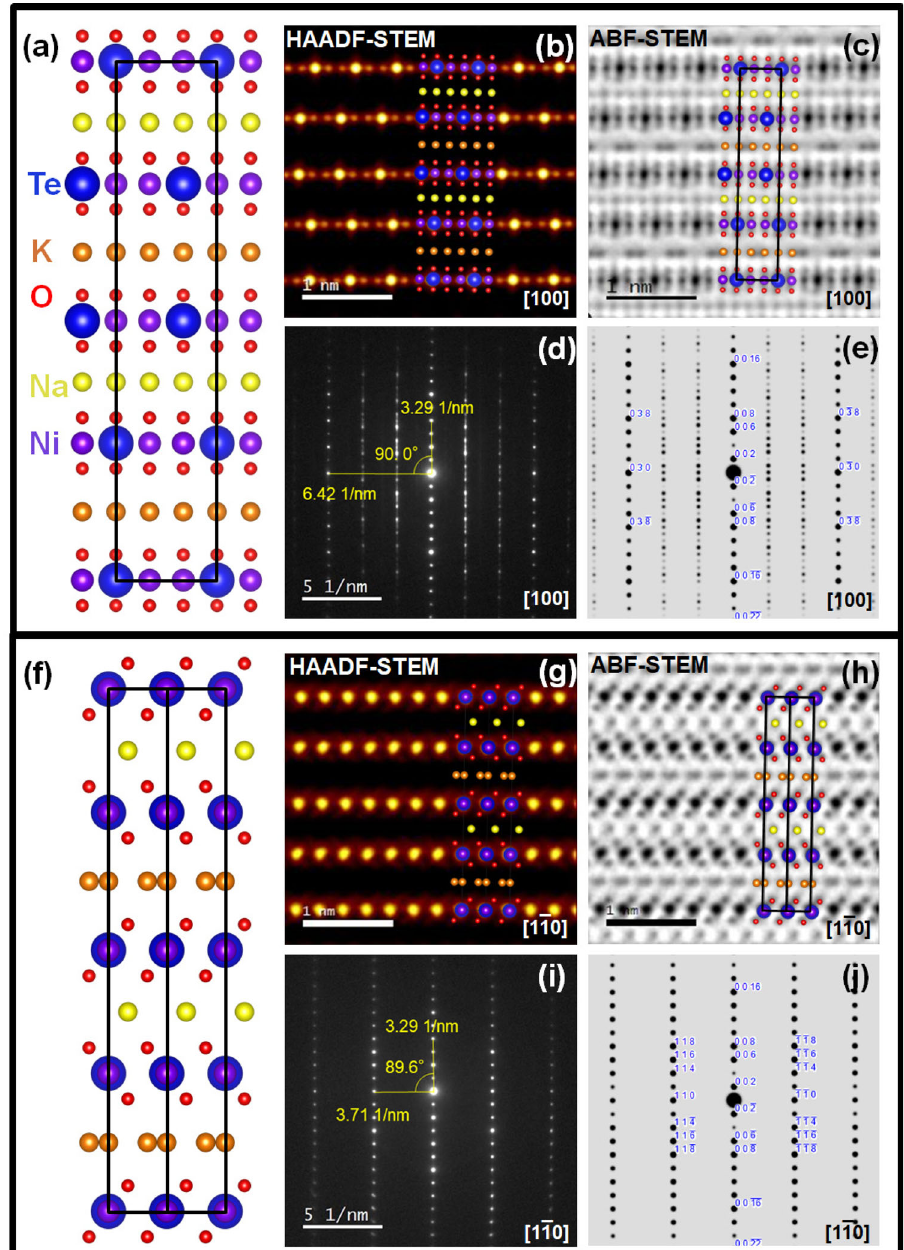
-- Fig. 3 Aperiodic atomic structure of NaKNi 2 TeO 6 along the [100] and the [1 (cid:1) 10] zone axes. a Atomistic model of the average aperiodic structure of NaKNi 2 TeO 6 acquired based on STEM analyses along the [100] zone axis. Black lines show the partial unit cell. b Superimposition of the model on a HAADF-STEM image, showing an excellent overlap between the positions of the Ni and Te atoms in the model that is in accord with the intensity distribution of the atom spots observed in the image. c Superimposition of the model on an annular bright- fi eld (ABF) image, af fi rming the atomic positions of Na, K and O. d Selected area electron diffraction (SAED) patterns taken along the [100] zone axis revealing spot shifts and streaks that are suggestive of the existence of aperiodicity. e Corresponding kinematic simulations based on the structural model shown in ( a ), showing agreement with the experimental results in ( d ). f Atomistic model of NaKNi 2 TeO 6 acquired based on STEM analyses along the [1 (cid:1) 10] zone axis. Black lines show the partial unit cell. Note the difference in the arrangement of atoms between Na (yellow) and K (orange) crystallographic sites. g Superimposition of the model on a HAADF-STEM image, af fi rming the atomic positions of Ni and Te. h Superimposition of the model on an ABF-STEM image, also showing an excellent overlap between the positions of the Na, K and O atoms in the model that is in accord with the intensity distribution of the atom spots observed in the image. i SAED patterns taken along the [1 (cid:1) 10] zone axis and j the corresponding kinematic simulations, validating good agreement with the experimental results shown in ( d